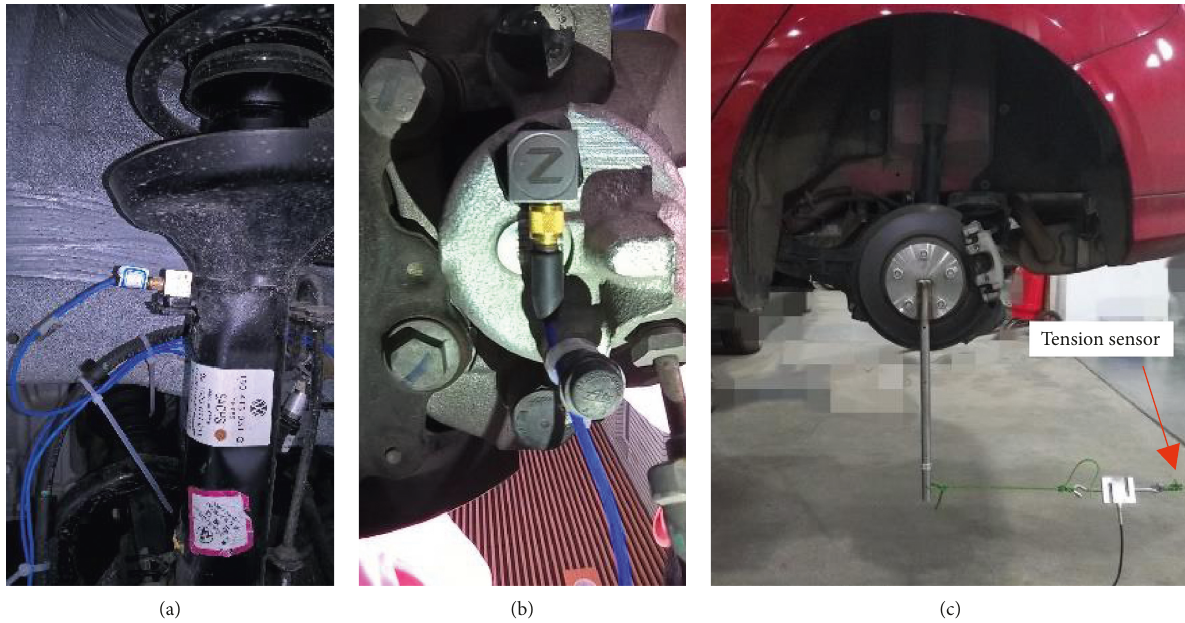
Figure 1: Sensors used to test brake creep groan: (a) accelerometer at strut and oil pressure sensor; (b) accelerometer at caliper; (c) tension